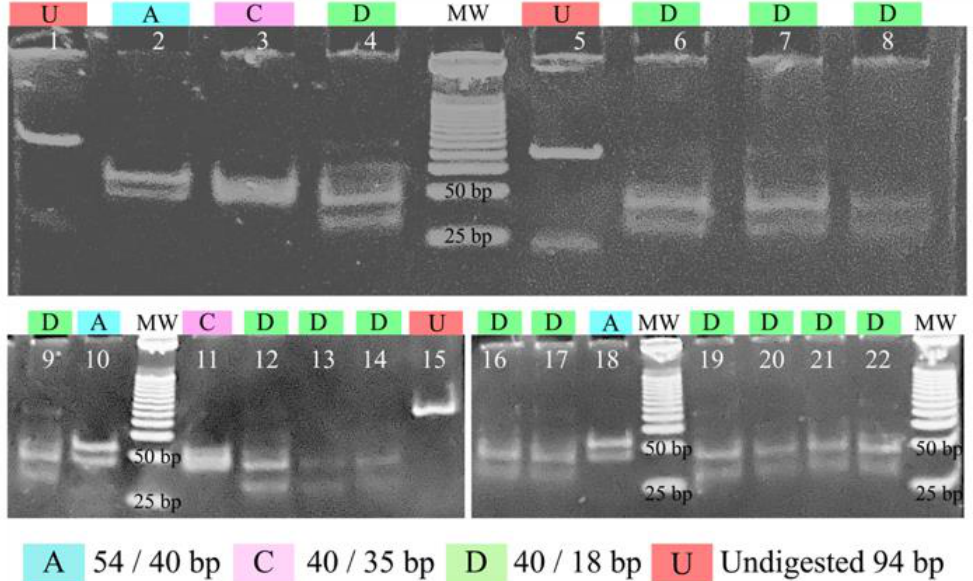
Figure 5. Polyacrylamide gel electrophoresis shows the restriction patterns of a fragment of the pfs47 gene digested with the enzyme MseI . Lanes 1, 5, and 15 show undigested amplification products, lanes 2 and 10 show strain 04/176, lane 18 shows a parasite of African origin isolated in Honduras, lane 3: strain K1, lanes 4, 6 – 9, 12 – 14, 16 – 17, 19 – 20: strains from Honduras and Nicaragua, lane 11: strain Dd2, lane 21: strain 7G8, and lane 22: strain HB3. MW: molecular weight marker of 25